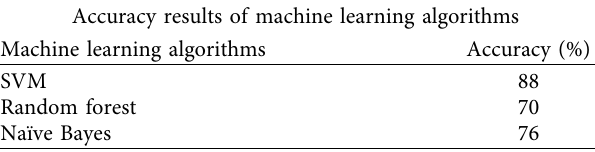
Table 1: Accuracy of machine learning algorithms.